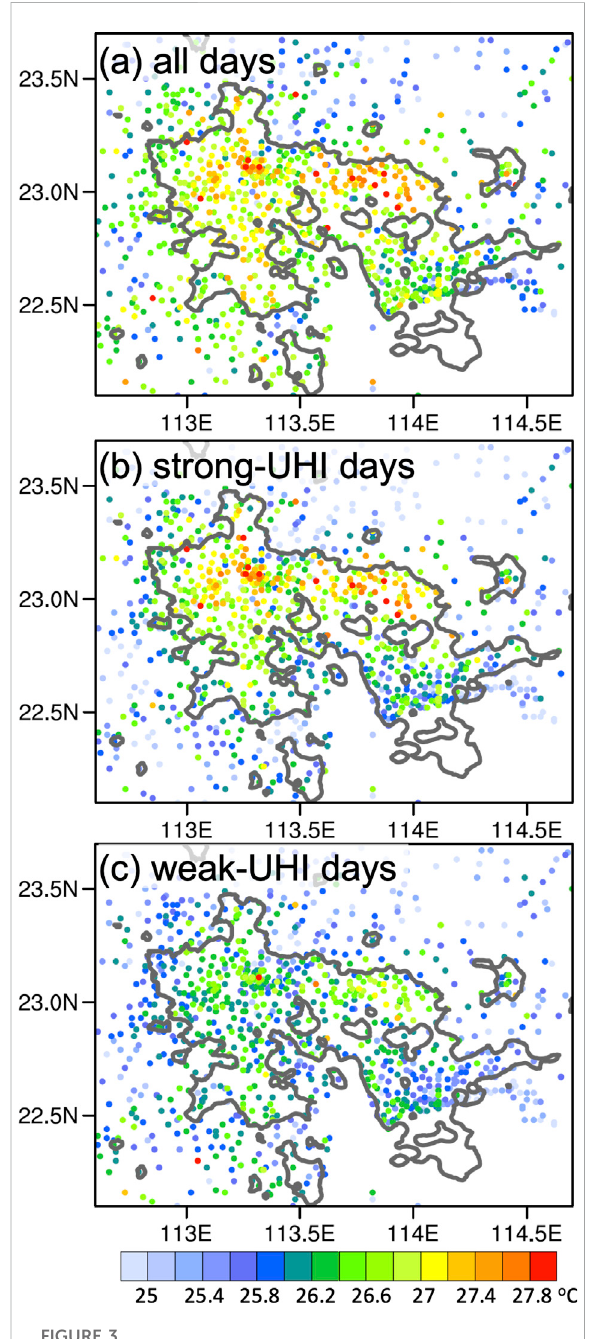
FIGURE 3 The observed daily average surface temperature (mm day − 1 ) for (A) alldaysfromApriltoJune2018, (B) strong-UHIdays,and (C) weak-UHI days.The grayisopleths denotetheurbanareas de fi ned the DMSP nighttime light data in